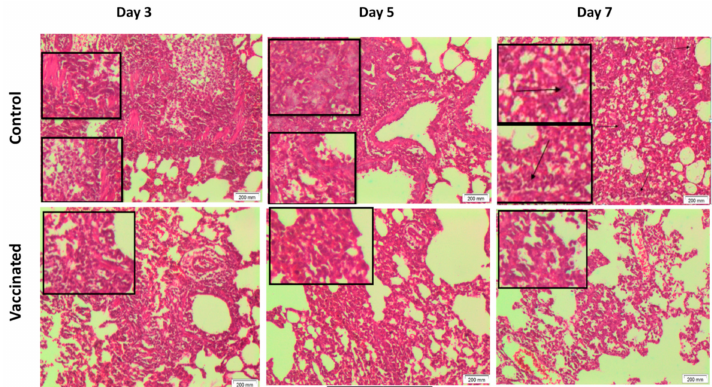
Figure 6. Histopathological examination of lungs of vaccinated and control challenged hamsters at different time points (H&E 100 × ). Vaccinated group showed better toleration and less inflammation after challenge viral infection than control group. Control group at day 3 and day 5 showed chronic inflammatory reaction, and chronic bronchitis affecting bronchial wall dissecting muscle wall. Also, control group at day 7 showed alveolar space with moderate edema, chronic bronchitis with marked inflammatory cells. The vaccinated group at day 3 and day 5 showed chronic inflammatory reaction, alveolar space with mild edema, and chronic bronchitis. Vaccinated group on day 7 showed alveolar space with mild edema, very minimal scattered inflammatory